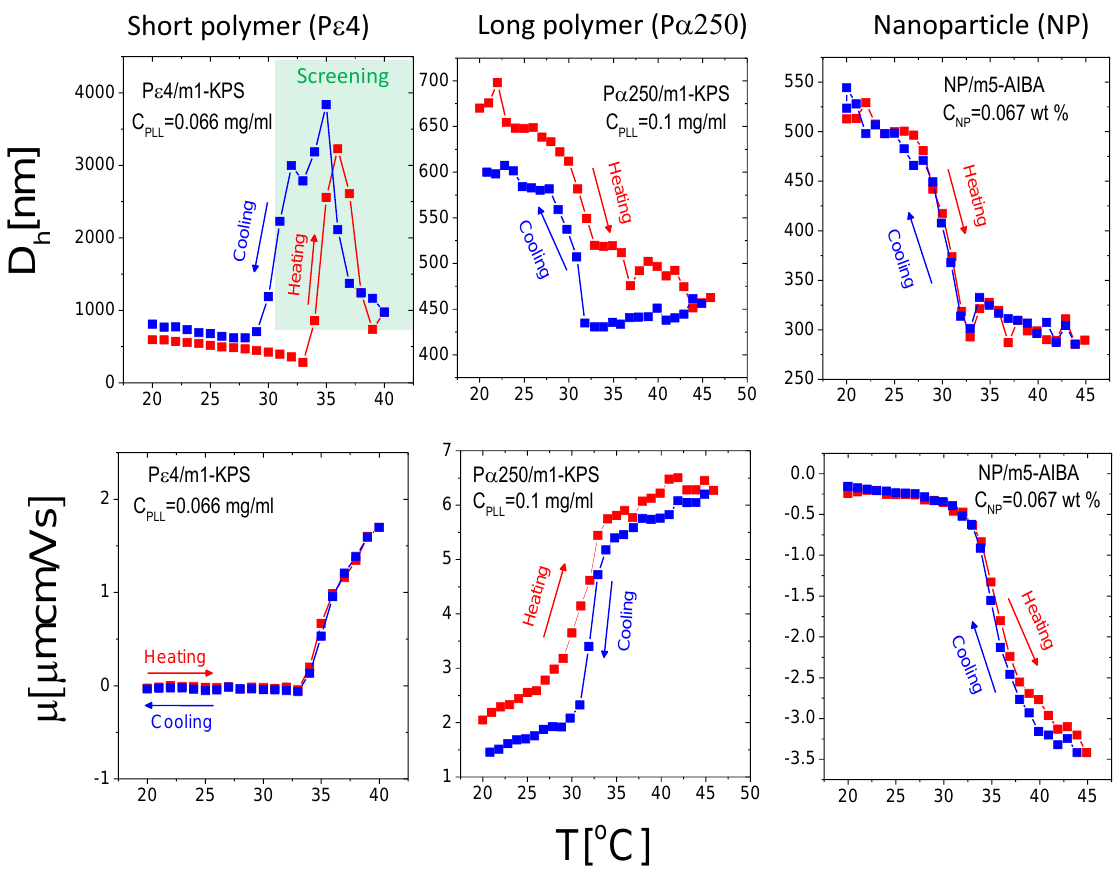
Figure 13. Hydrodynamic diameter D h ( upper panels ) and electrophoretic mobility µ ( lower panels ) as a function of temperature during heating (red squares) and cooling (blue squares) ramps with thermalization time 300 s for P ε 4/m1-KPS ( left panels ), P α 250/m1-KPS ( middle panels ) and NP/m5-AIBA ( right panels ). Additive concentrations are indicated in the panels and correspond to the formation of overcharged complexes. Symbols in the shaded region for P ε 4/m1-KPS mixtures correspond to samples where flocculation occurred because of the high screening given by the free P ε 4 chains. A pronounced hysteretic behavior of both mobility and size has been detected only for P α 250/m1-KPS mixtures, suggesting different time scales of adsorption and desorption of long polyelectrolytes. By contrast, the full reversibility obtained for NP/m5-AIBA complexes points to a quasi-instantaneous rearrangement of NP as temperature is increased or